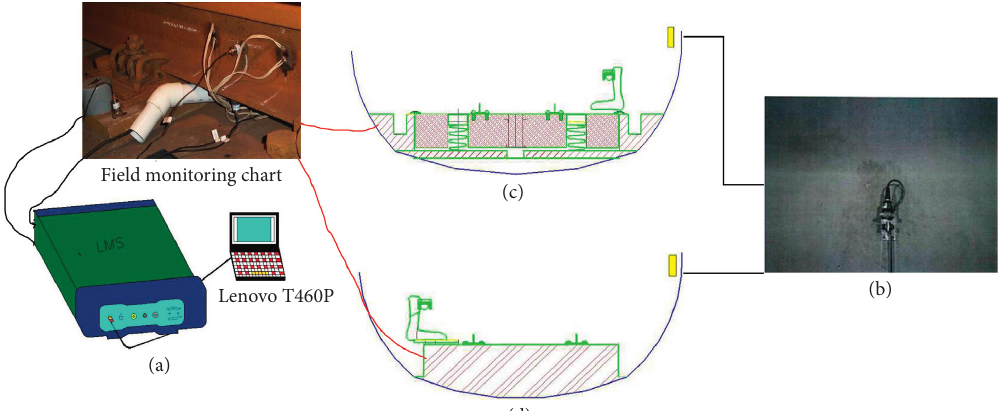
Figure 16: (a) LMS signal acquisition analyzer. (b) Vertical acceleration sensor. (c) Schematic diagram of measuring points of floating plate trackbed section. (d) Schematic diagram of measuring points of the integral trackbed section.